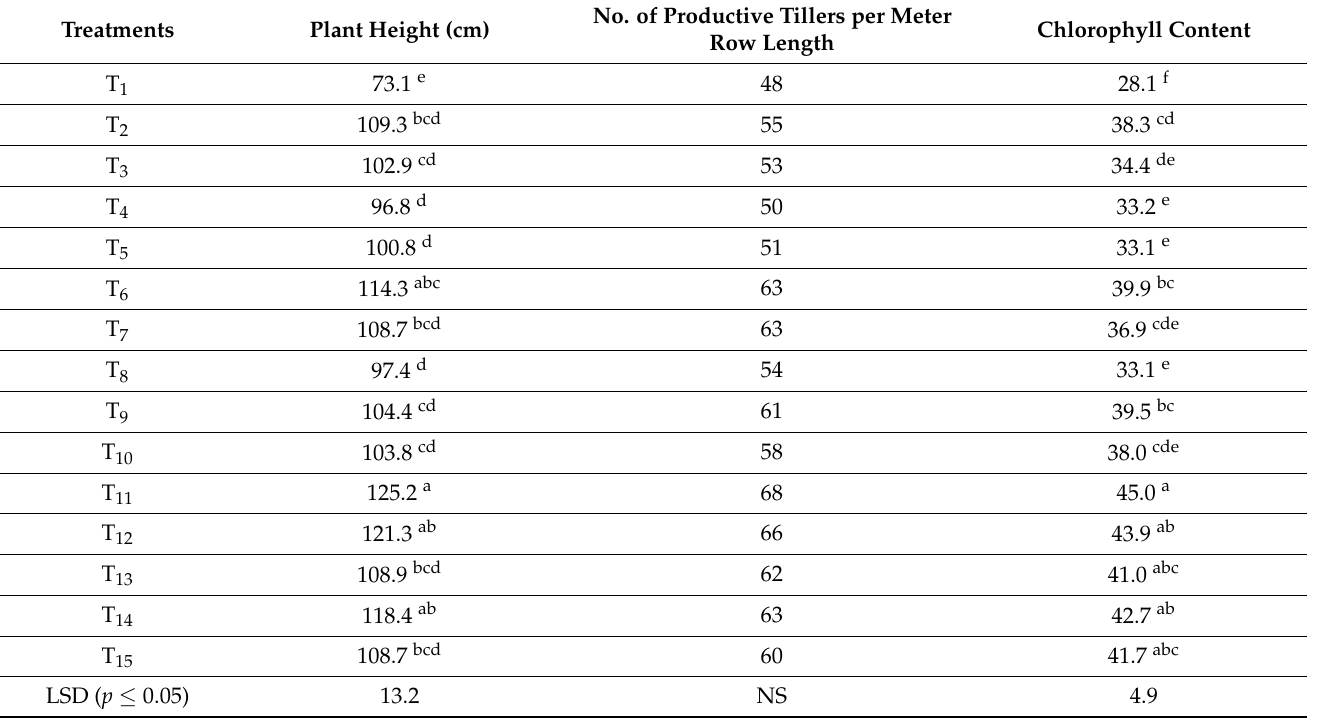
Table 2. Effect of different fertilizers and manures on plant growth and yield attributes of